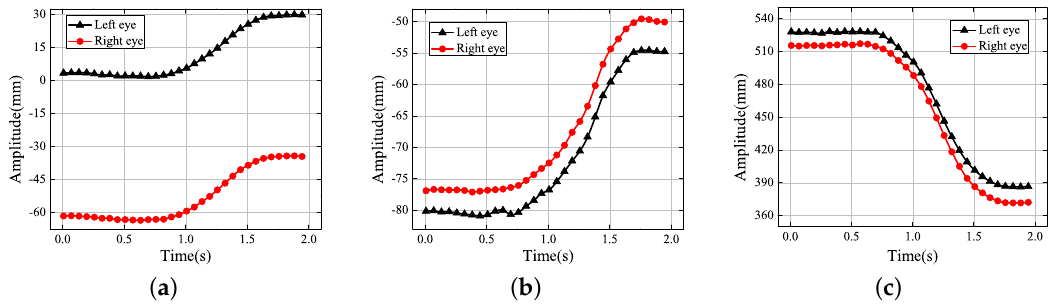
Figure 13. Experimental results obtained during car braking: ( a ) X axis; ( b ) Y axis; ( c ) Z axis.